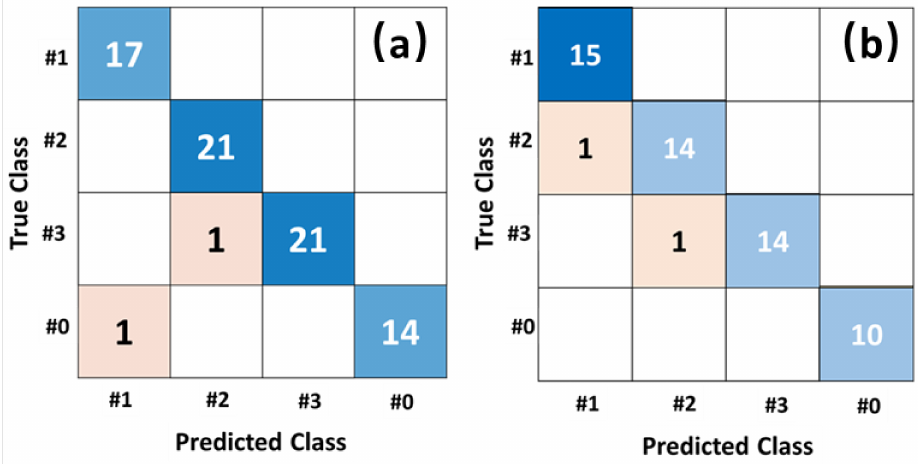
Figure 8. ( a ) The confusion matrix of the 2D CNN and ( b ) the confusion matrix of the 1D